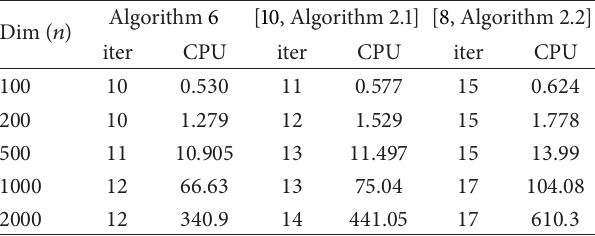
Algorithm 2.2 in [8]. The choices of the parameters for the latter two algorithms are what the corresponding references